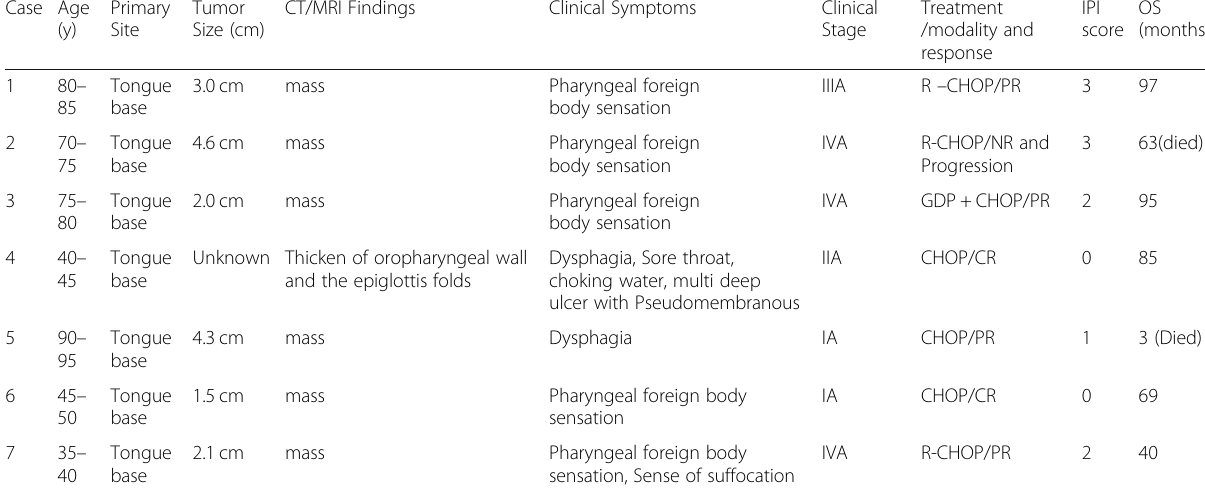
Table 1 Summary of clinical characters of tongue lymphomas Case Age